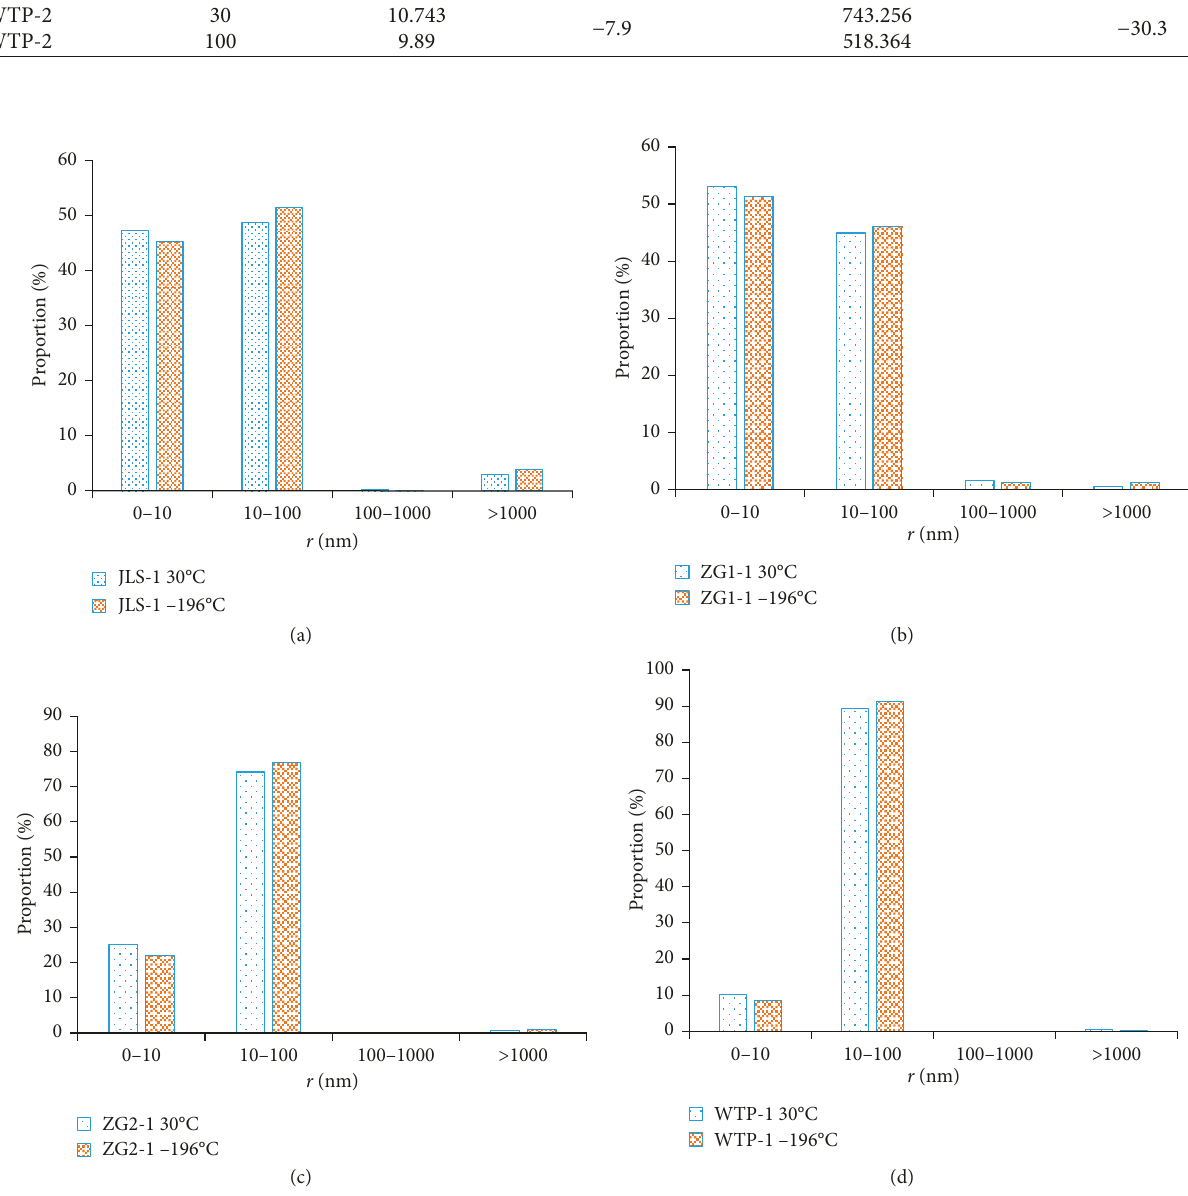
Figure 3: Histogram of pore size distribution of coal samples under low